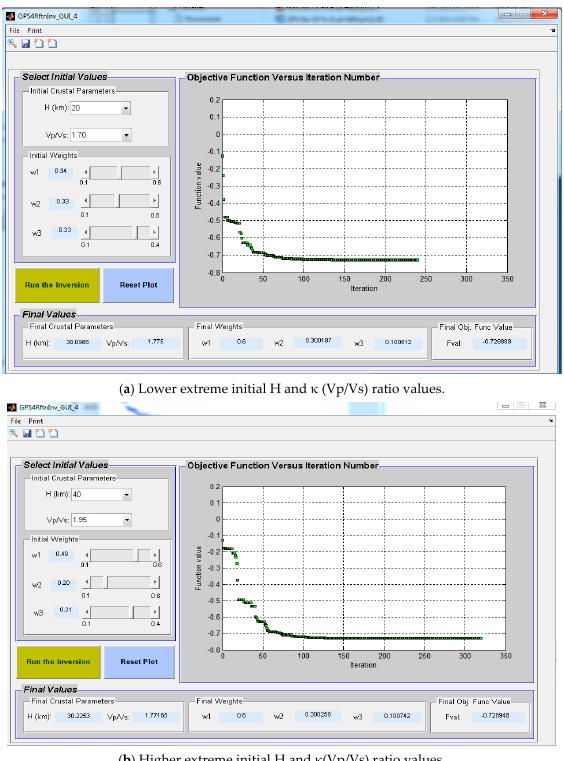
Figure 3. Figure displaying two extreme initial values for the region of investigation. ( a ) Smallest and ( b ) highest initial parameter values. ( b ) highest initial parameter